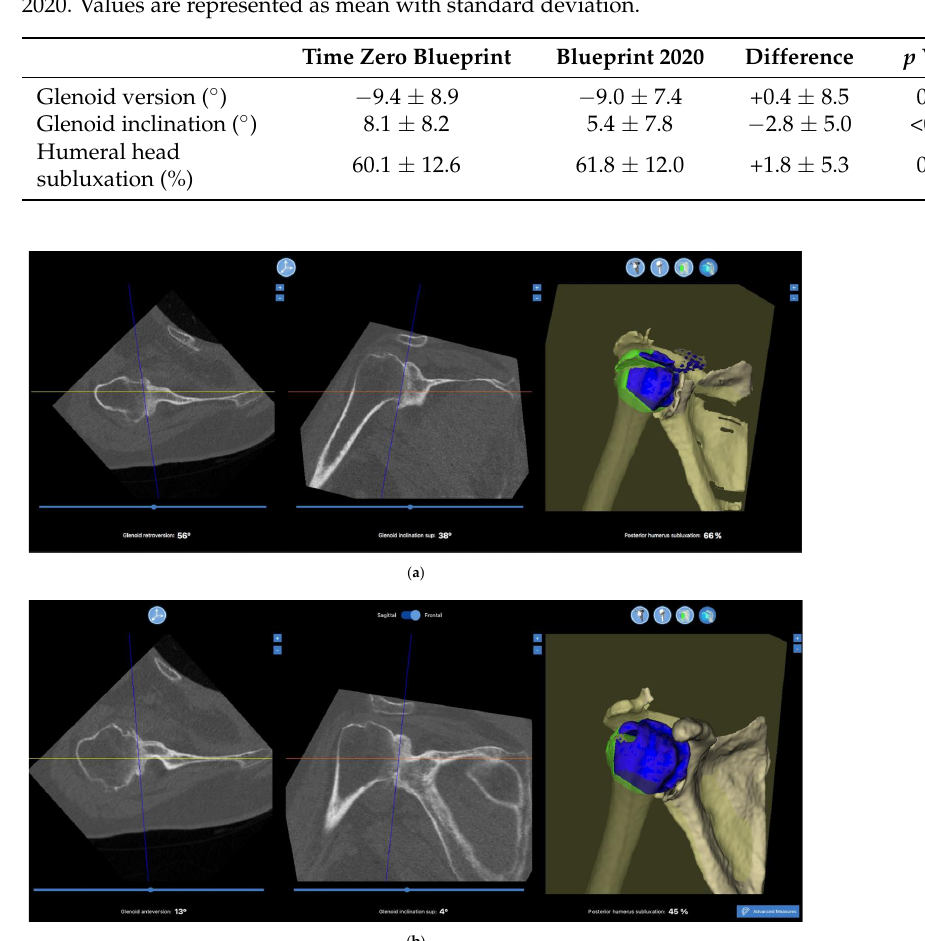
Figure 1. Two images depicting glenoid and joint alignment parameters of same patient with Time Zero Blueprint ( a ) and Blueprint 2020 ( b ). The humeral head subluxation evaluations were not significantly different among the two software versions, with 60.1 ± 12.6 and 61.8 ± 12.0, respectively (mean difference = 1.8 ± 5.3, p = 0.115; Table 2). Figure 2 shows a Bland–Altman plot comparing the glenoid and joint alignment parameters with the two software versions. A difference >5° between the